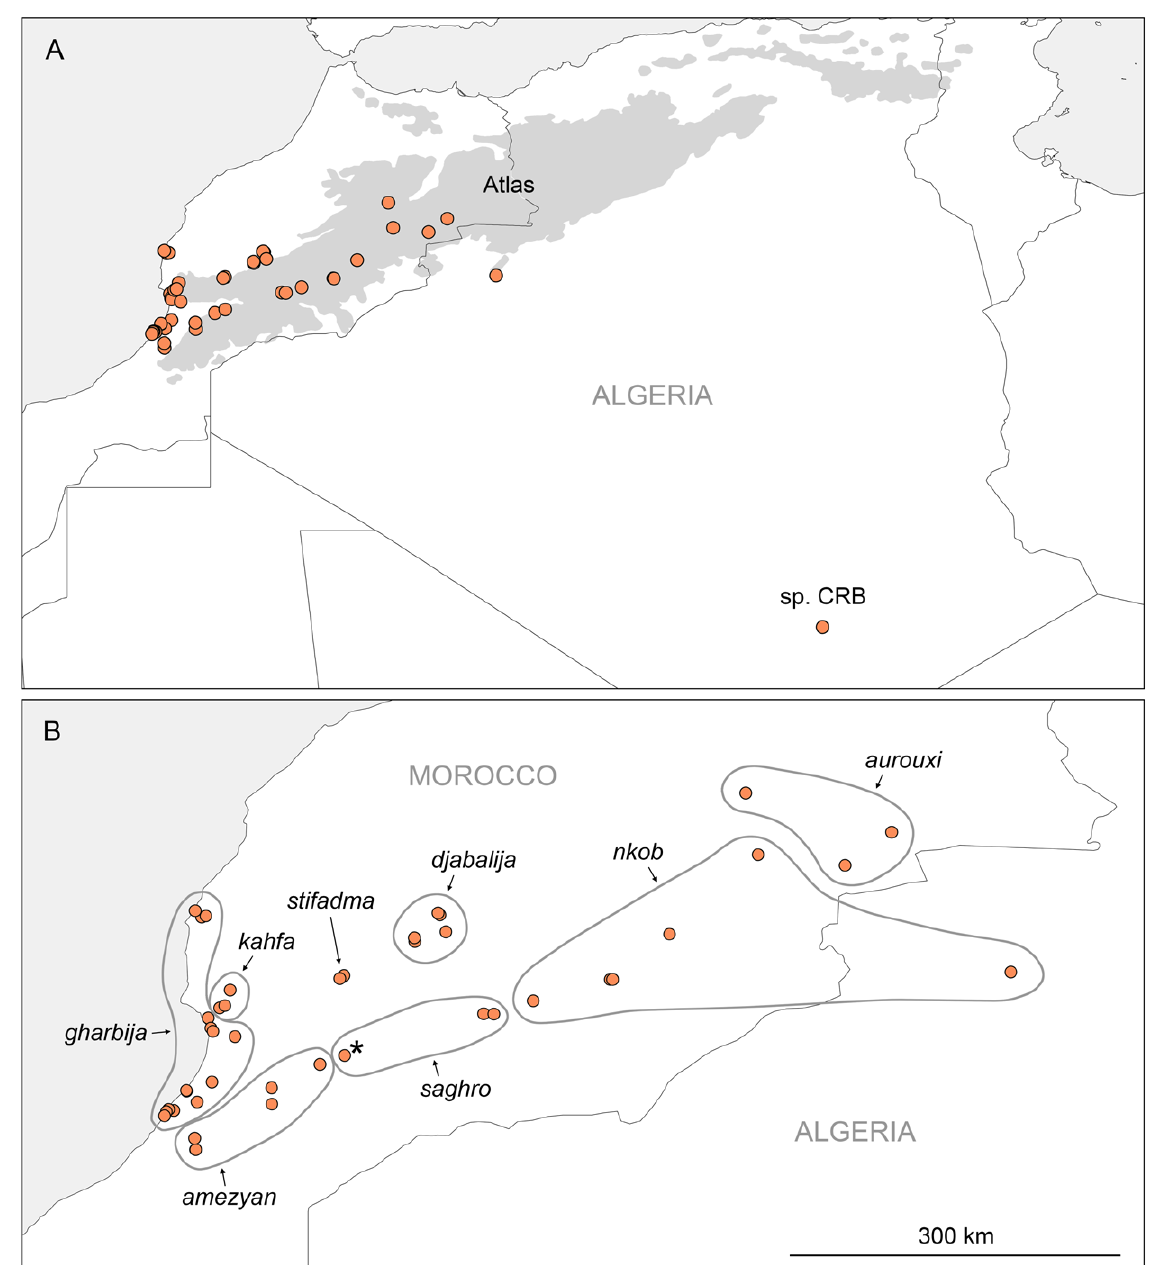
Fig. 163. Known distribution of Maghreba gen. nov. A . Complete known distribution, including an undescribed Algerian species in CRB; the approximate extent of the Atlas Mountains is shown (1000 m altitude isolines, taken from https://www.britannica.com/). B . Known distributions of named species. Asterisk: specimens tentatively assigned to M. aurouxi gen.